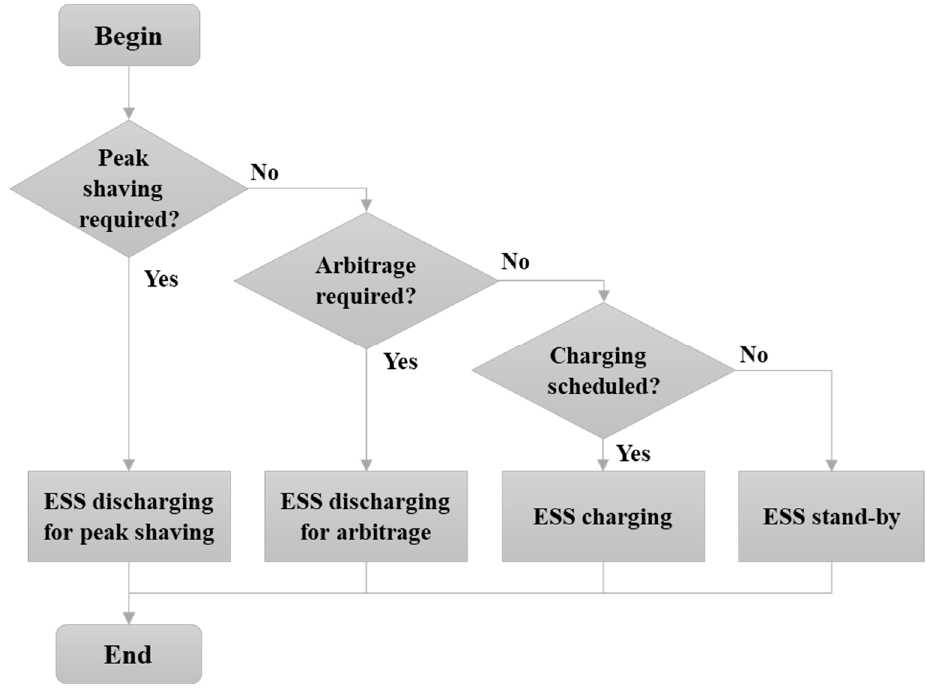
Figure 1. Flowchart of an algorithm for conventional ESS-based DSM.